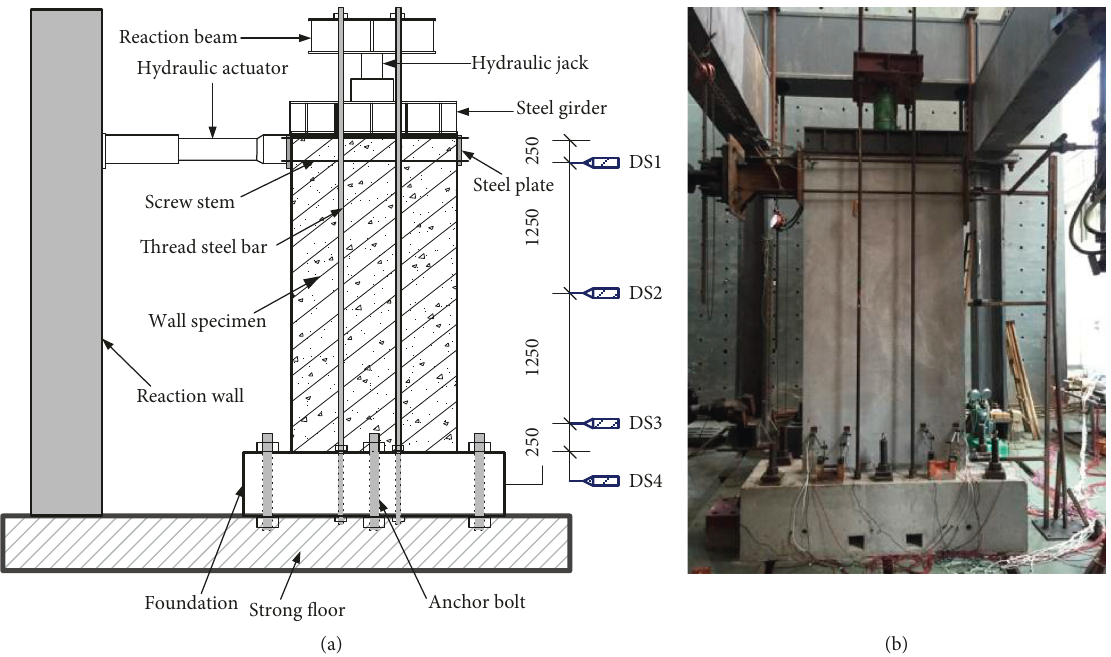
Figure 12: The details of test setup (unit: mm): (a) test setup of the specimen and (b) test